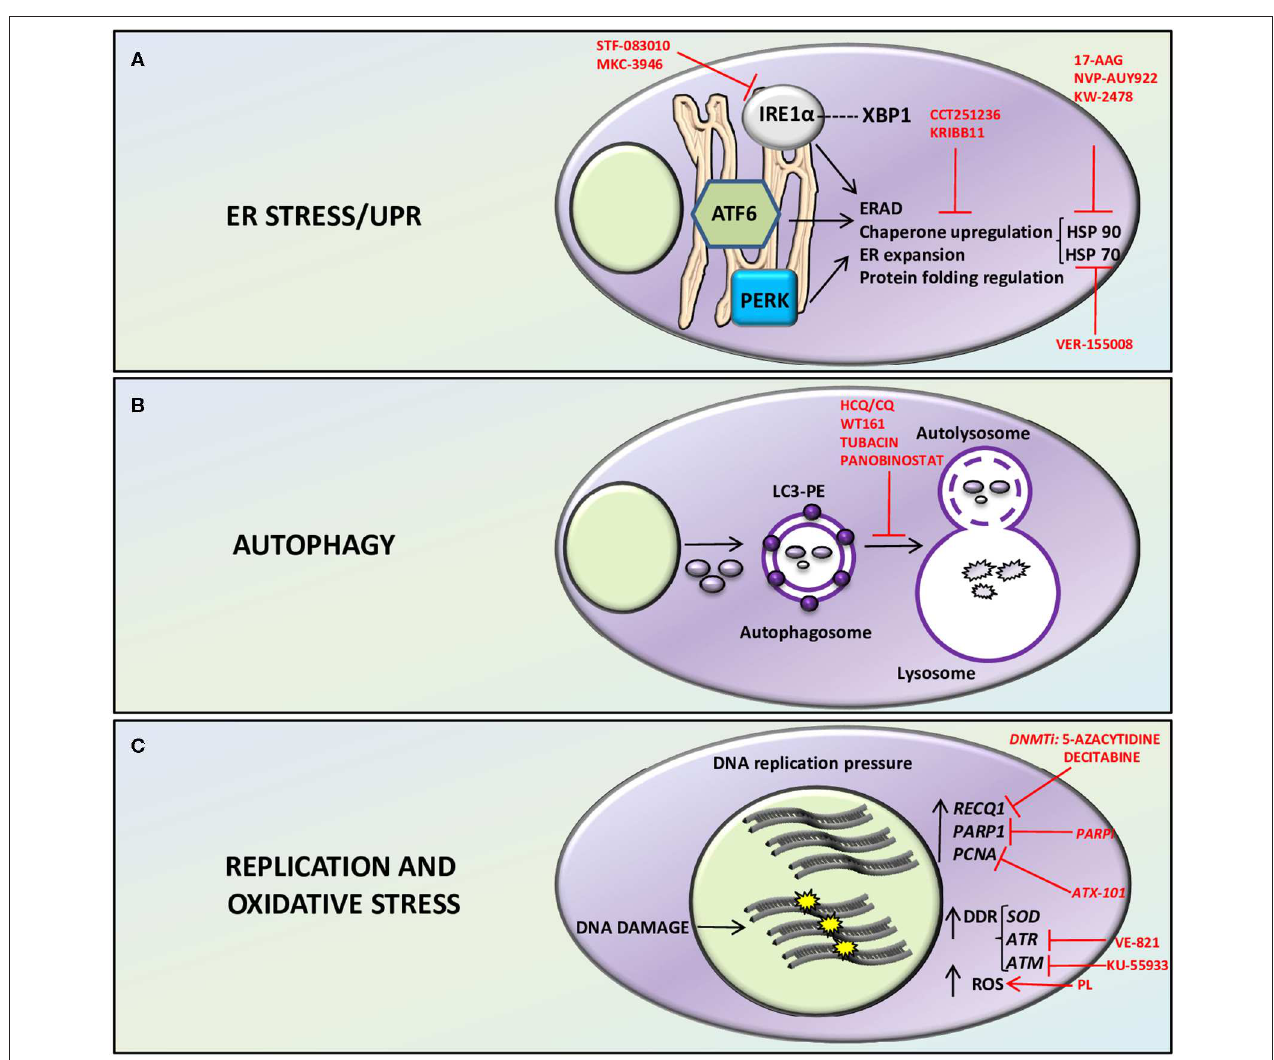
FIGURE 1 | Therapeutically relevant Stress related pathways in MM. ER stress/UPR (A) , autophagy (B) , and replication and oxidative stress (C) related pathways and putative therapeutic targets in MM plasma cells. (A) the ER, resident stress sensors IRE1 α , PERK, and ATF6 are activated by accumulation of misfolded proteins and sustain MM cell survival by ERAD (ER associated protein degradation) and by protein folding regulation through upregulation of chaperones such as HSP70 and HSP90. Inhibition of HSP90 with 17-AAG, NVP-AUY922, KW-2478, or HSP70 with VER-155008 or both chaperones via inhibition of their regulator HSF-1 with the compounds CCT251236 or KRIBB11 has cytotoxic effect on MM cells. IRE1 α inhibition with STF-083010 or MKC-3946 displayed anti-myeloma activity. (B) Autophagy, by recycling proteins and organelles avoids cell death. In particular, it conveys cellular components to lysosomes, through the formation of autophagosomes and autolysosomes with the activation of a series of autophagy related proteins (ATGs) and the conjunction of LC3-I with phosphatidylethanolamine (PE) to form the lipidated form LC3-II. Inhibitors of autophagy such as Hydroxychloroquine (HCQ)/Chloroquine (CQ), or HDAC inhibitors such as WT161, tubacin, and panobinostat has been employed to interfere with autophagy and hamper protein homeostasis, leading to MM cell death. (C) MM plasma cells display high DNA replication pressure with the consequent likelihood of exposition to DNA damage. MM plasma cells rely on high expression of replication related proteins such as PCNA, PARP, and RECQ1 helicase. DNA damage response (DDR) and oxidative stress are chronically activated in MM through the stimulation of DNA stress managing proteins such as ATR, ATM, SOD, and ROS production. RECQ1, PARP1, PCNA, and DDR inhibitors and compounds that interfere with oxidative stress are depicted in the figure. DNMTi, DNA methyltransferase inhibitors; PARPi, PARP inhibitors; PL,